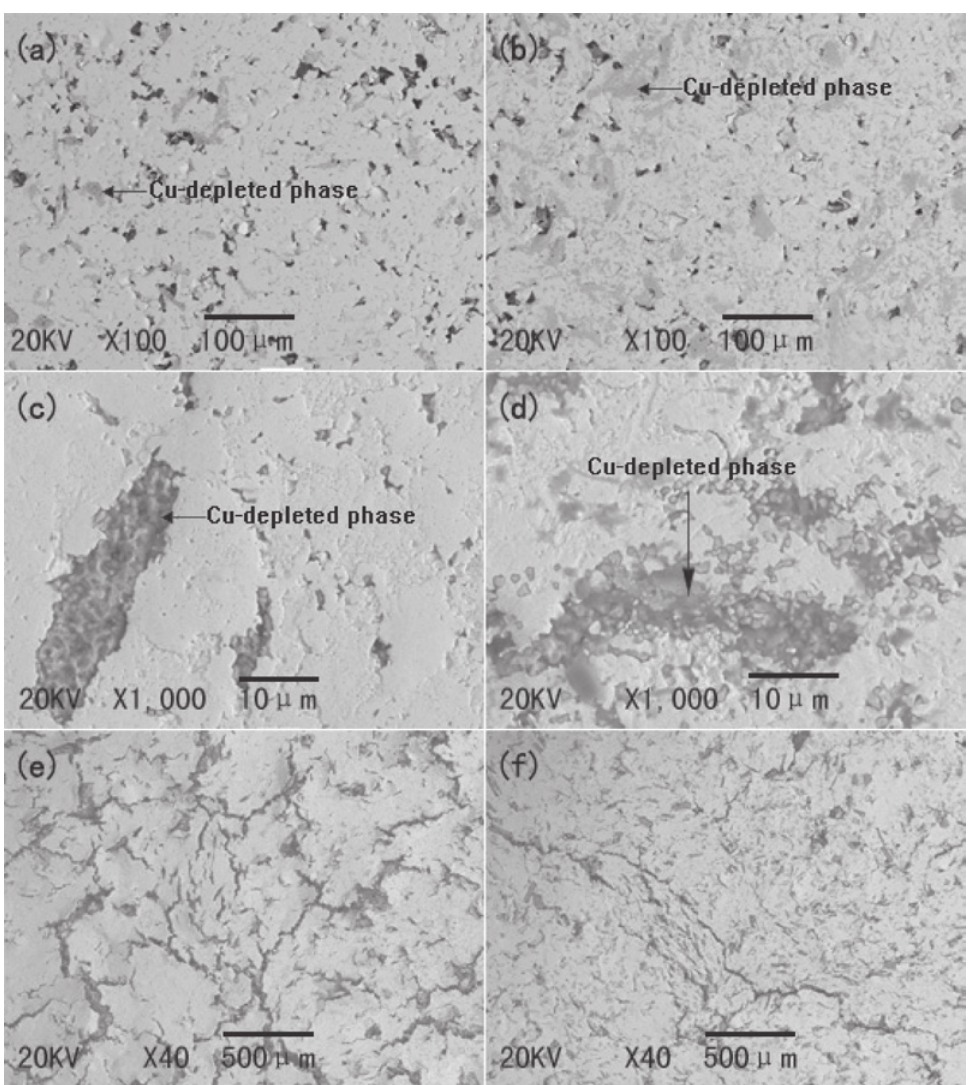
Fig. 5: SEM images of porous Cu-35mass%Ni-5mass%Cr (a: 0 h, c: 3 h, e: 10 h) and Cu-35mass%Ni-10mass%Cr (b: 0 h, d: 3 h, f: 10 h) alloys corroded in molten (0.62Li,0.38K) 2 CO 3 at 650 °C in air for different immersion